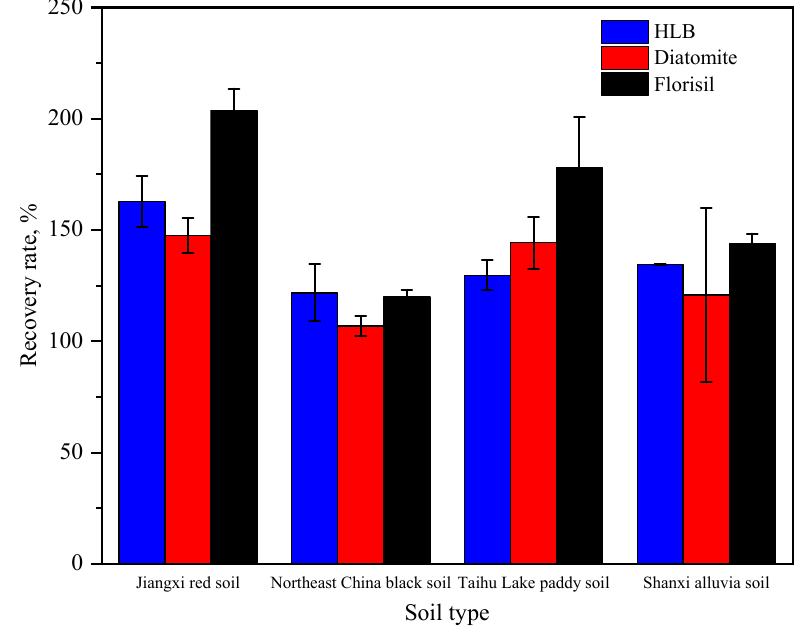
Figure 5. Recoveries of GLUF-Ps derived by different purifications in four soils.